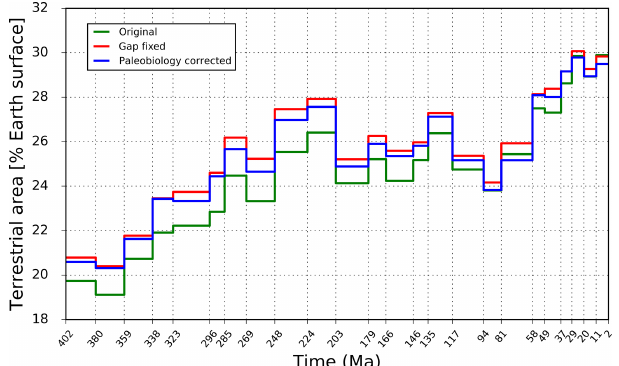
Figure 10. Terrestrial areal change due to filling gaps and modify- ing the paleo-coastlines and paleogeographic geometries over time. Green: based on the original paleogeographic maps of Golonka et al. (2006); red: based on paleogeography reconstructed using a dif- ferent plate motion model of Matthews et al. (2016) and gaps filled; blue: based on paleogeography with gaps fixed and revised using the paleoenvironments indicated by marine fossil collections from the